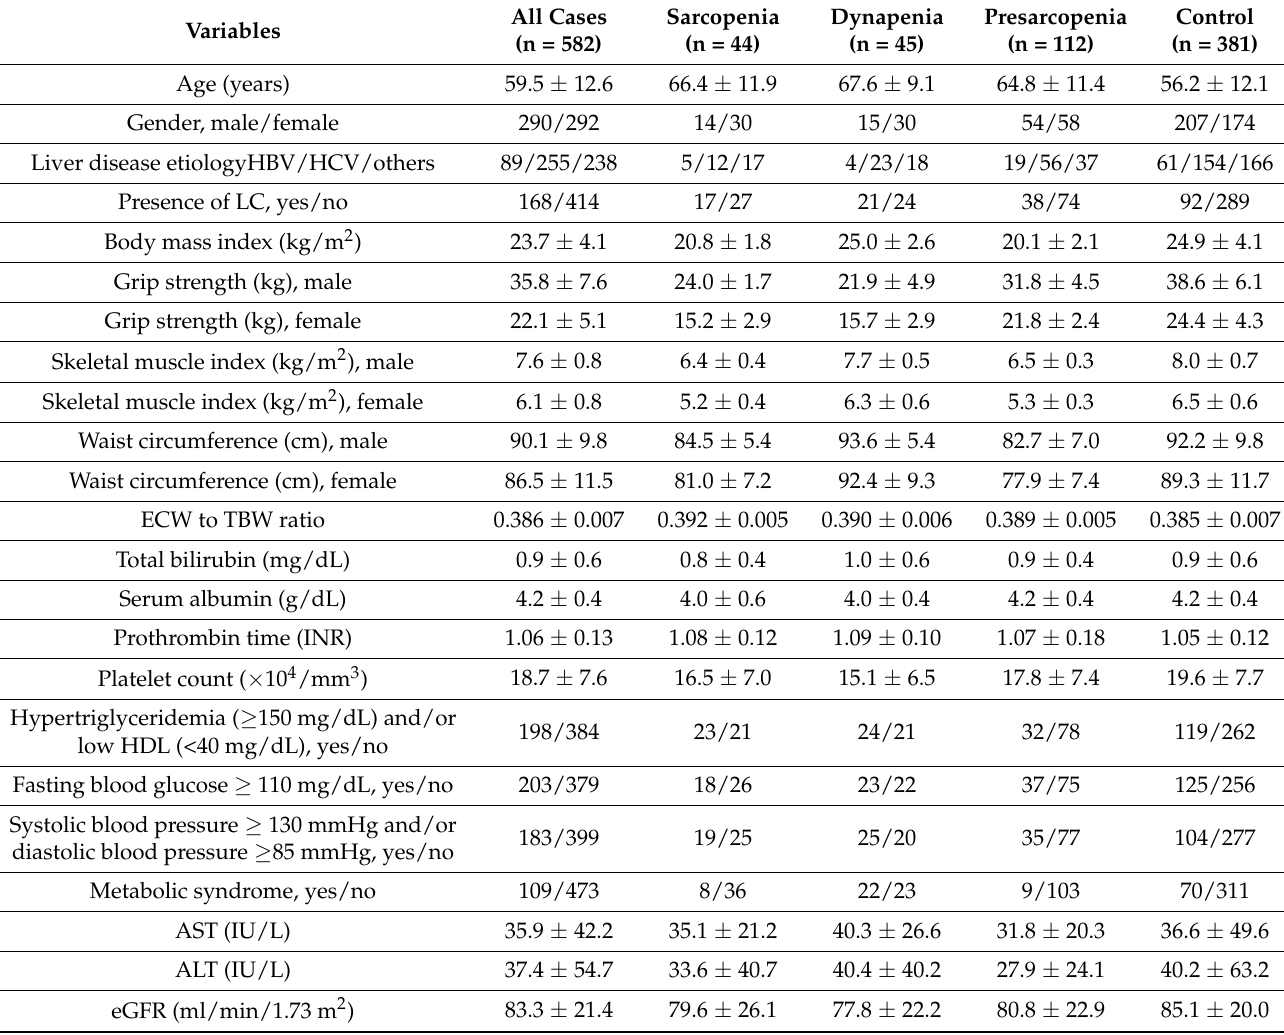
Table 1. Baseline characteristics (n =